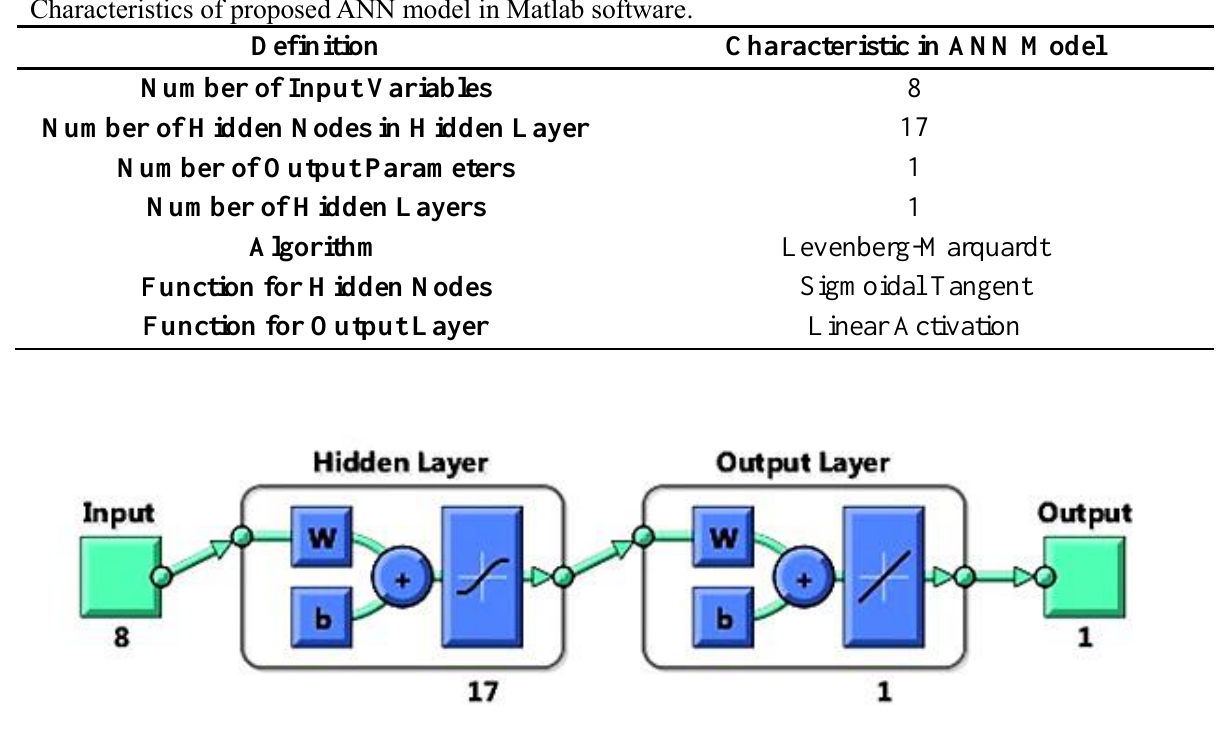
Fig. 7. Structure of ANN modeling in Matlab software with 8 input parameters, 17 hidden neurons in the hidden layer, one output variable, one hidden layer, and one output layer.